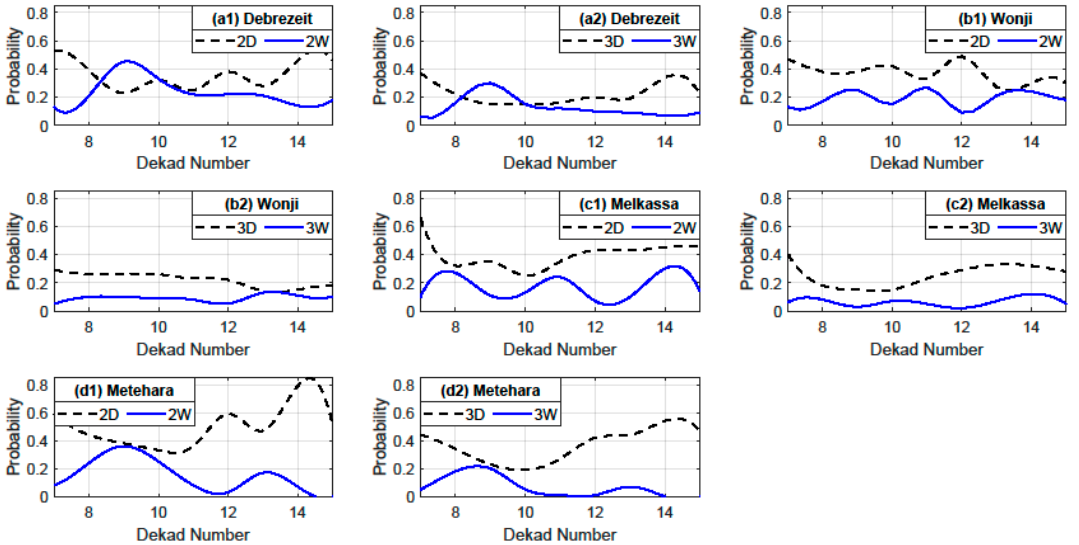
Figure 5. Probability of consecutive dry and wet dekads (2 D , 2 W , 3 D and 3 W ) in the Belg seasons.